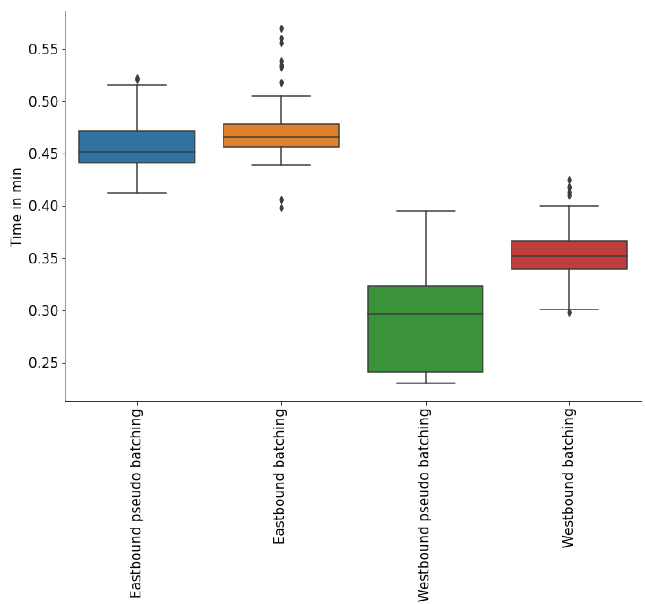
Figure 14. Figure shows boxplots of the time per epoch for both